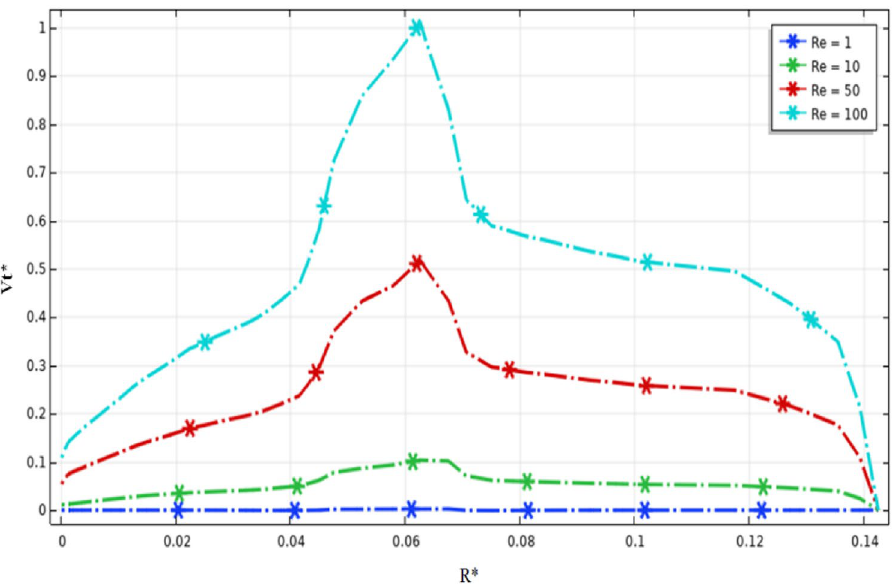
Figure 9. Velocity magnitude distribution Vt ∗ in the horizontal radial section on the stirred tank for different Reynolds numbers.